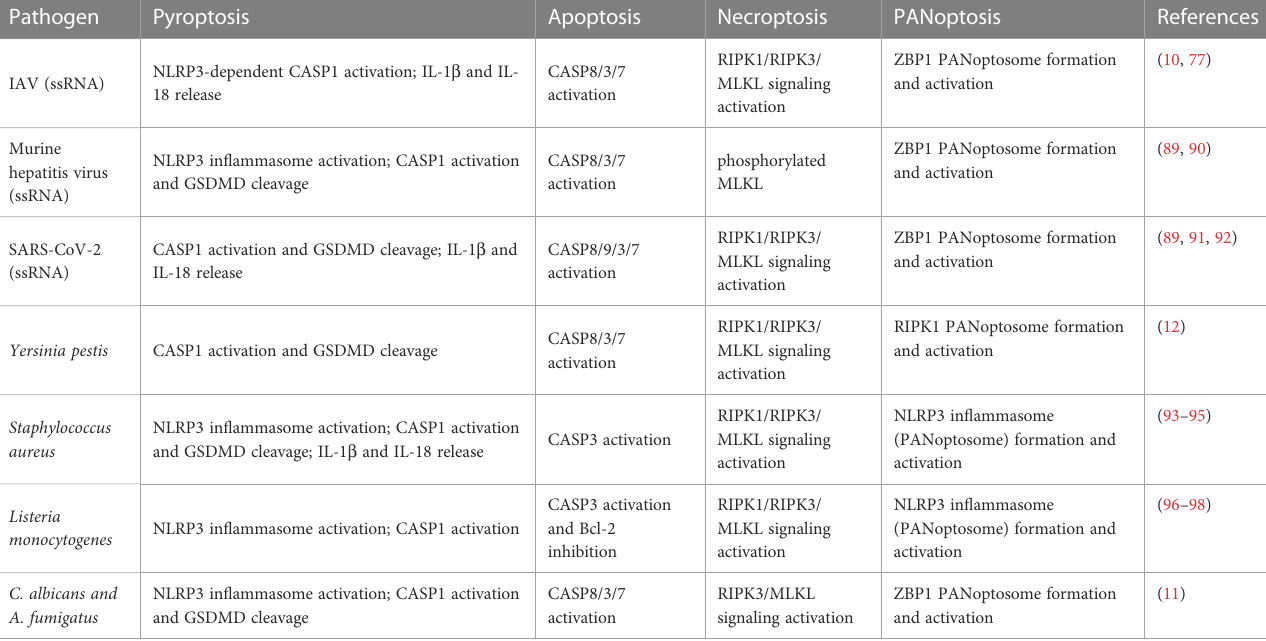
TABLE 1 Pathogens that can induce pyroptosis, apoptosis, and necroptosis in macrophages.